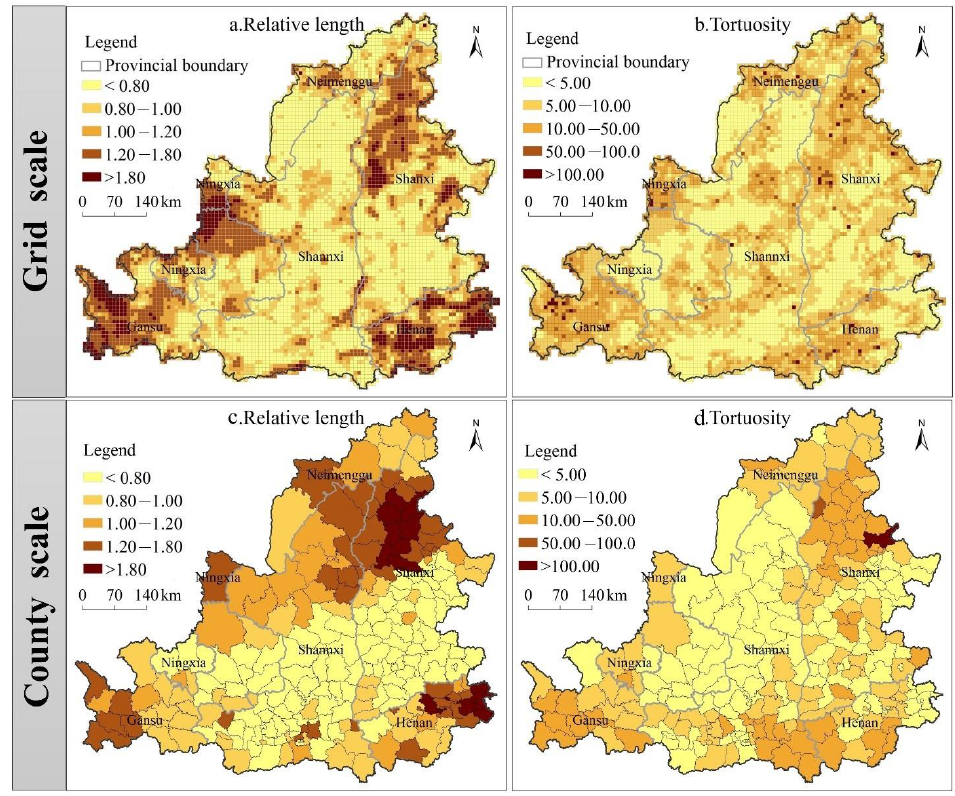
Figure 7. Spatial distribution of relative lengths and tortuosity of LISA temporal paths.